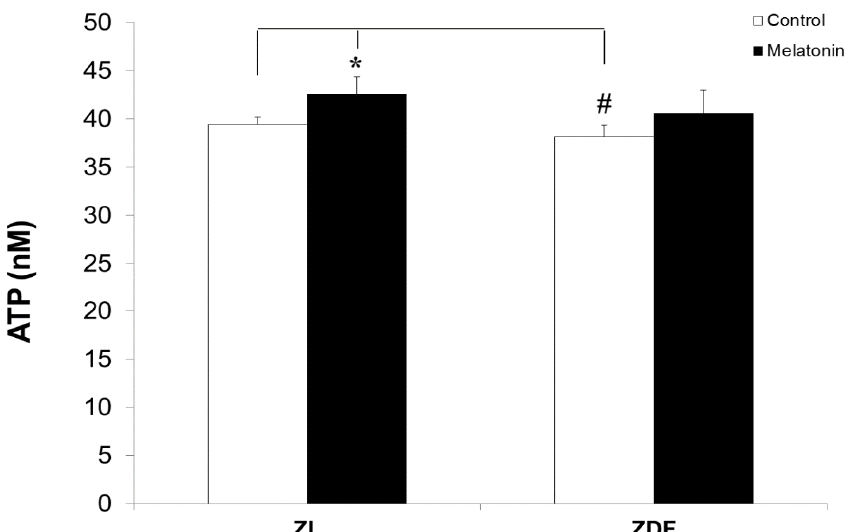
Figure 4. ATP levels of BAT-isolated mitochondria of different treated groups. Data were normalized for variations in mitochondrial content in an equivalent amount of tissue (micrograms of ATP/mg of tissue wet weight), adjusted to 0.5 mg/mL protein concentration, and expressed as nmol/mg protein. Data are shown as mean ± SD. Superscript characters show significant differences determined by two-way ANOVA followed by the Tukey post hoc test ( * p < 0.01, M-ZL compared with C-ZL rats; # p < 0.05, C-ZDF compared with C-ZL rats).